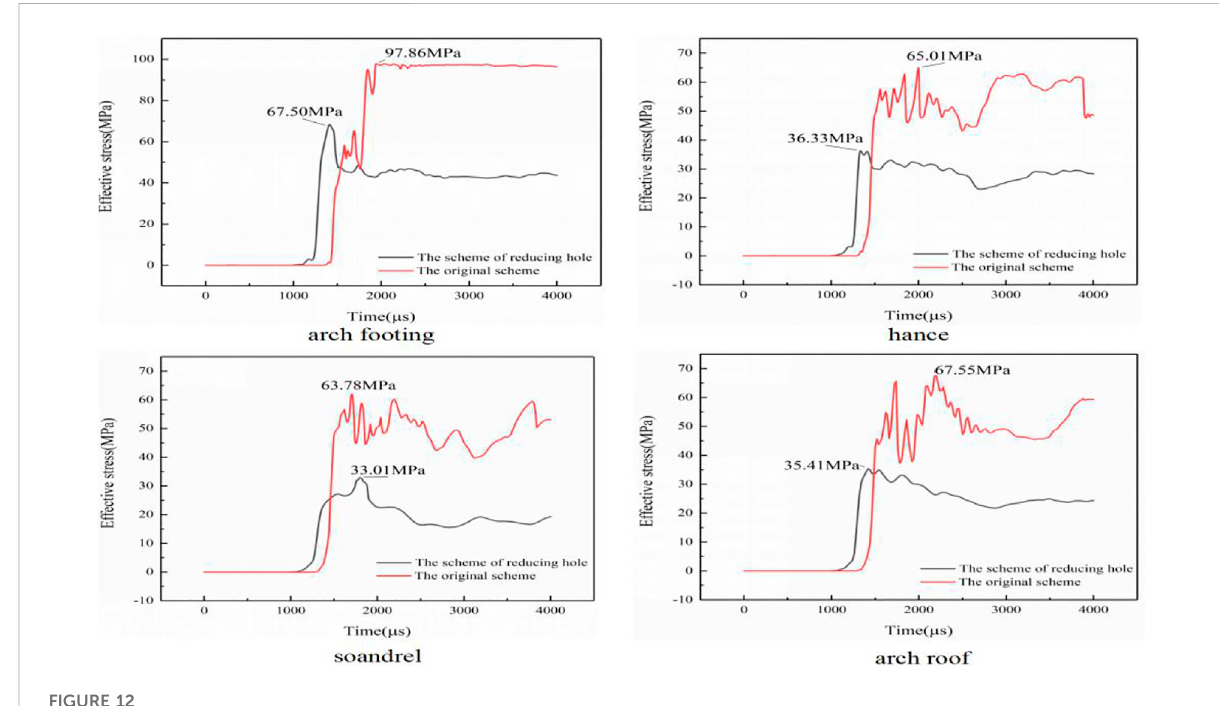
FIGURE 12 Effective stress.